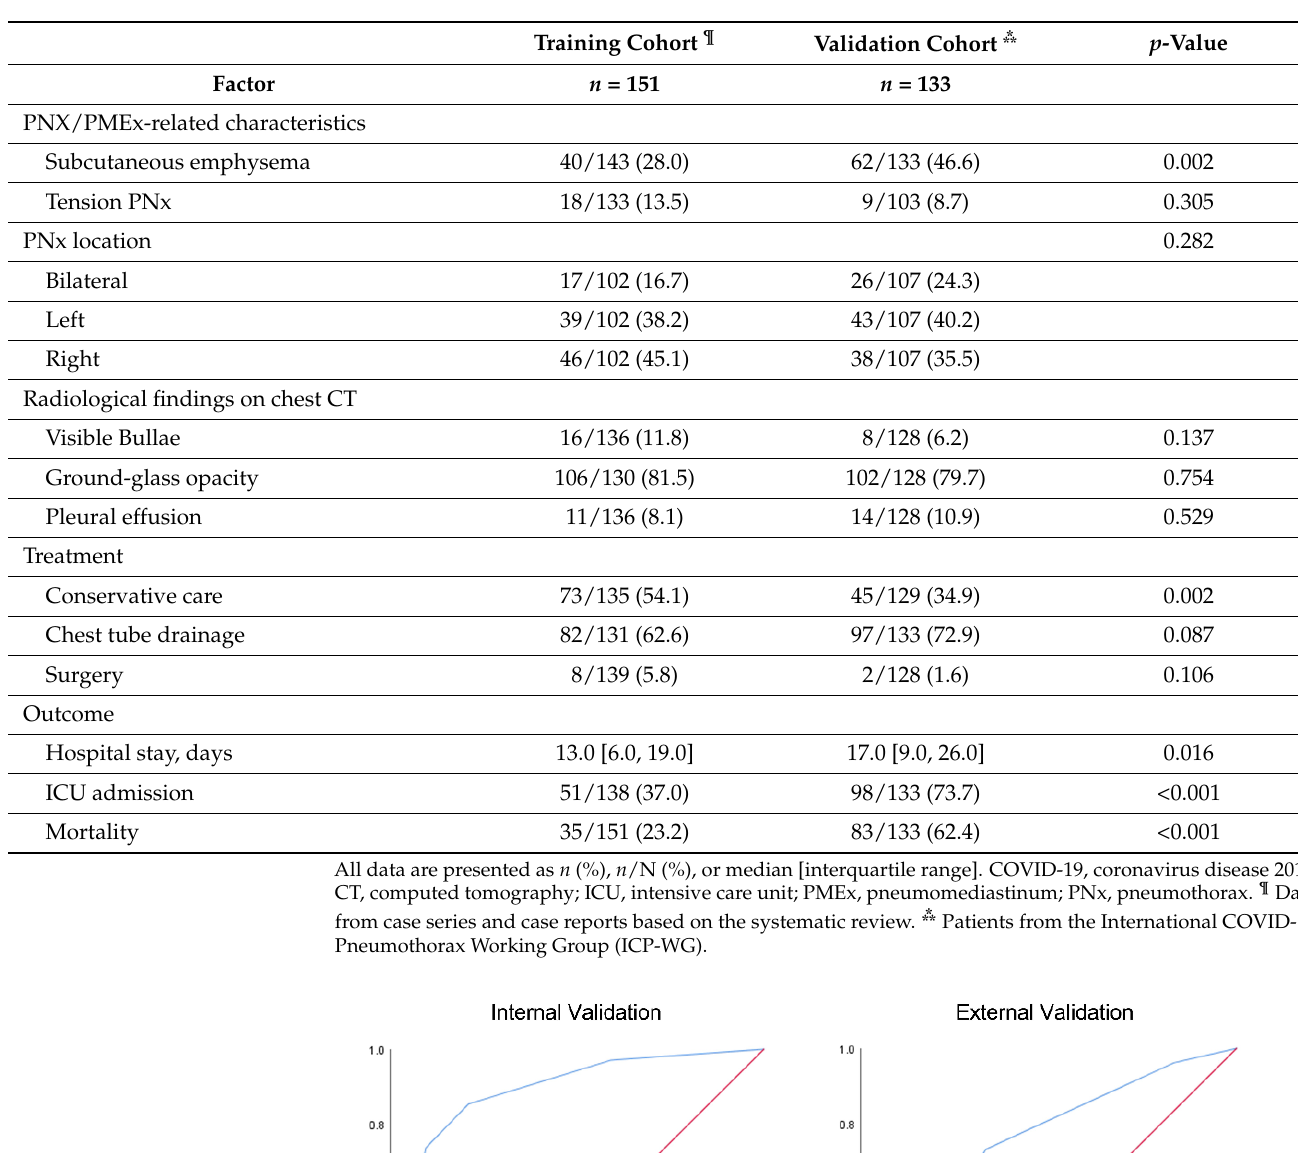
Table 4. Clinical characteristics and outcomes of patients: comparison of the training and validation Table 4. Cont. cohorts.